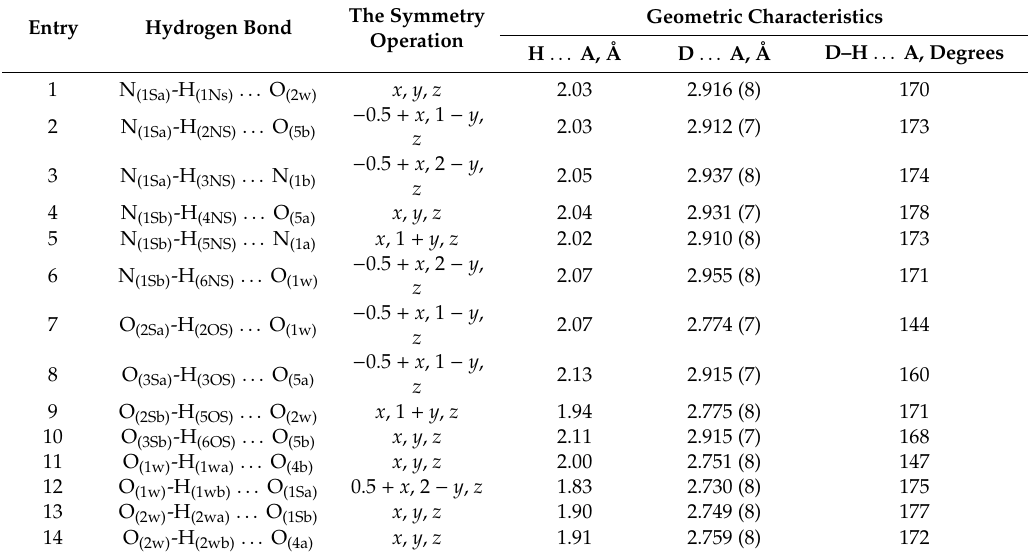
Table 1. Intermolecular hydrogen bonds in the structure of salt 5a and their geometric characteristics. The Symmetry Geometric Entry Hydrogen Bond Operation